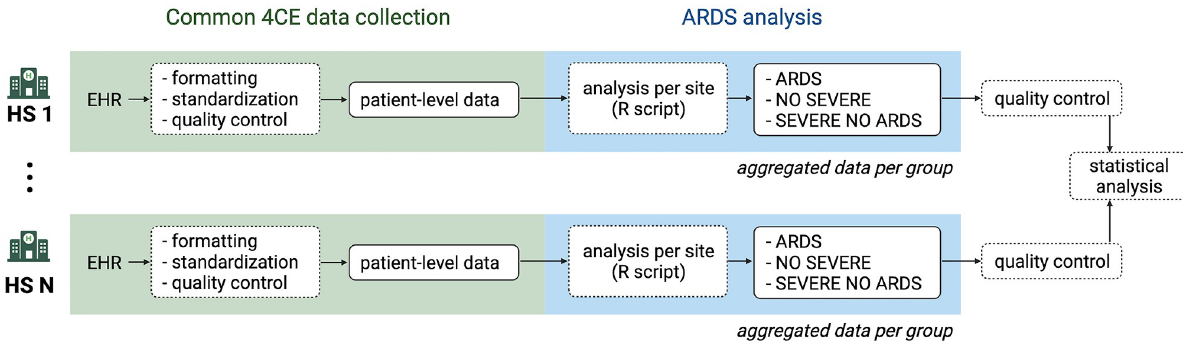
Fig 1. Study workflow. From EHR extraction to ARDS analysis on aggregated data (HS: healthcare system).